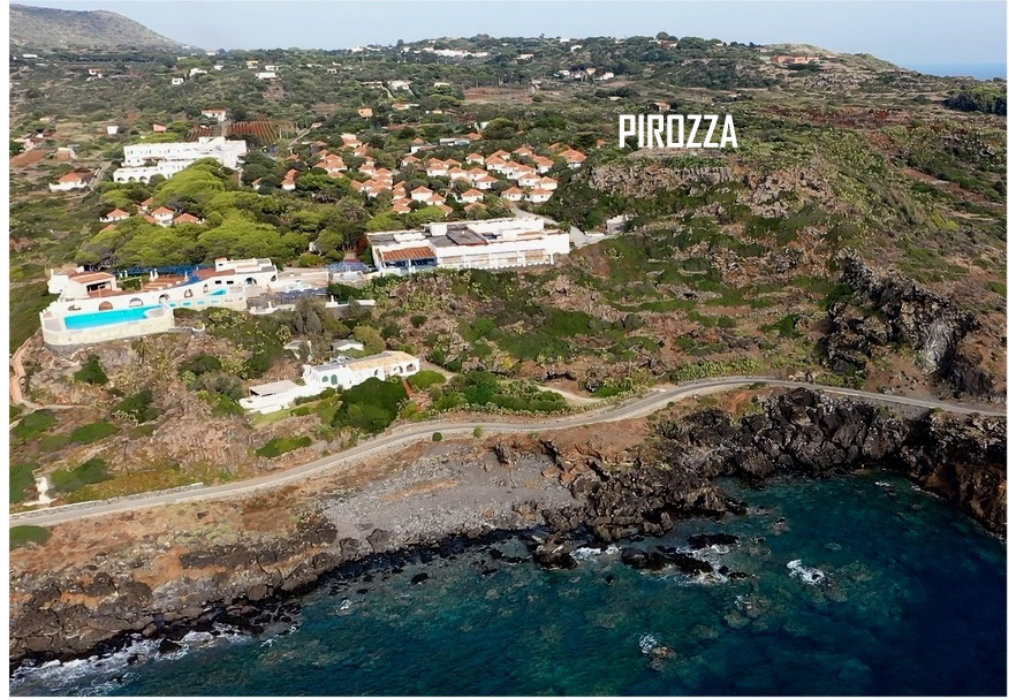
Figure 3: View by drone of the Pirozza-Spalmatore hill, on the southwestern side of Ustica, the first known place of Neolithic colonization on Ustica (courtesy of INGV Remote Sensing Laboratory, Rome,